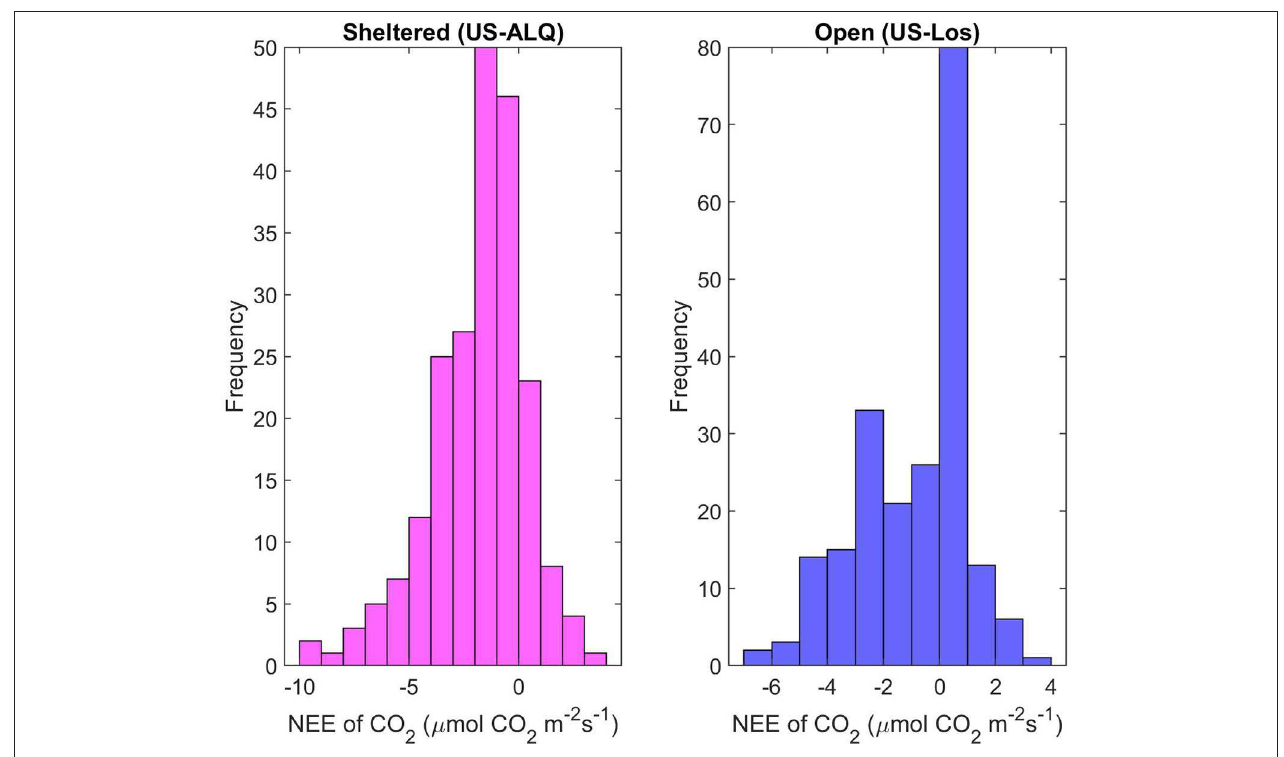
FIGURE 9 | Histograms of daily mean NEE for each site for growing season 2016. Pink, sheltered fen (US-ALQ); blue, open fen